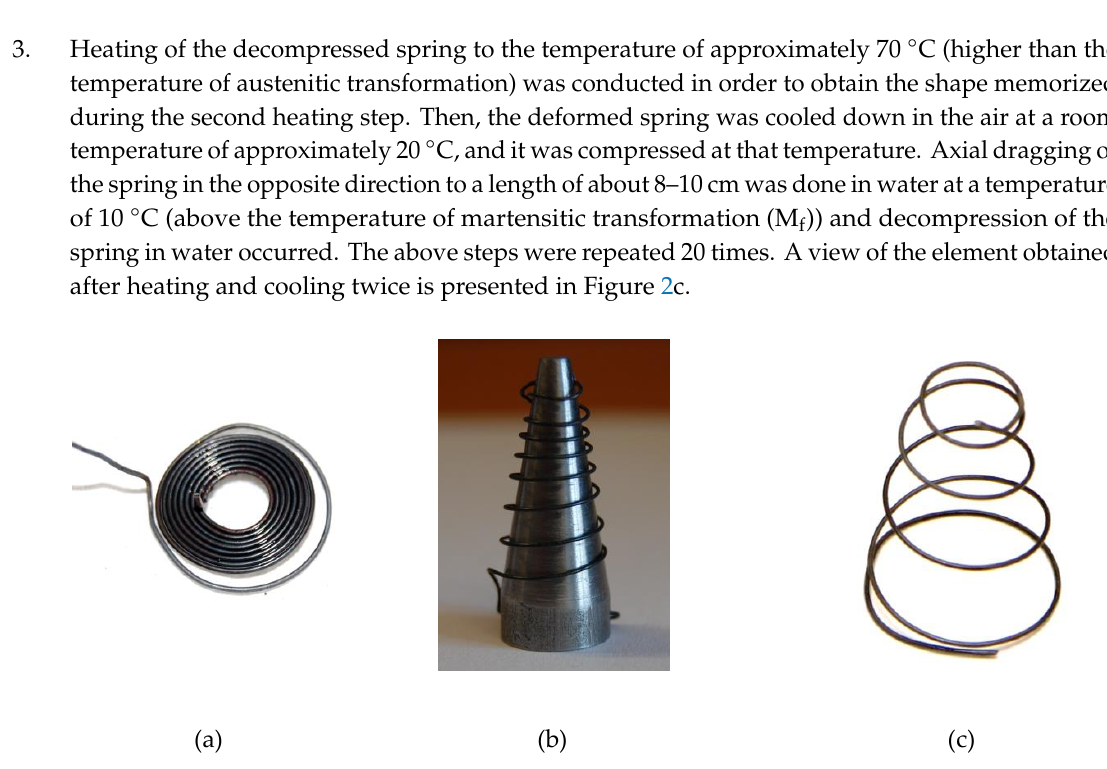
Figure 2. Views of smart elements during the thermomechanical treatment. ( a ) A view of the smart element obtained after the first heating step, ( b ) The spring put onto a metal cone for the second heating step, ( c ) A view of the element obtained after heating and cooling twice.